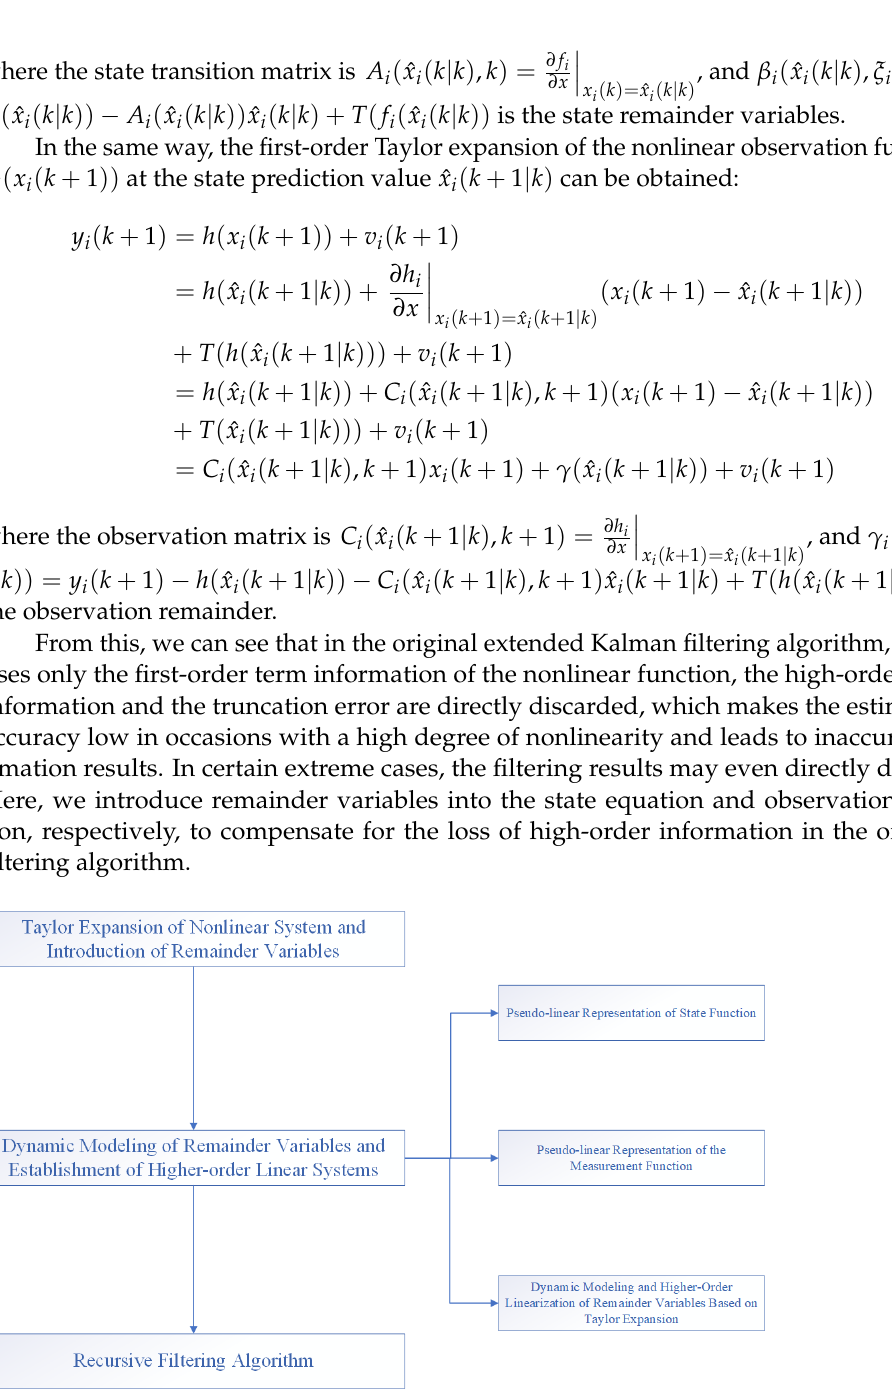
Figure 1. Algorithm block